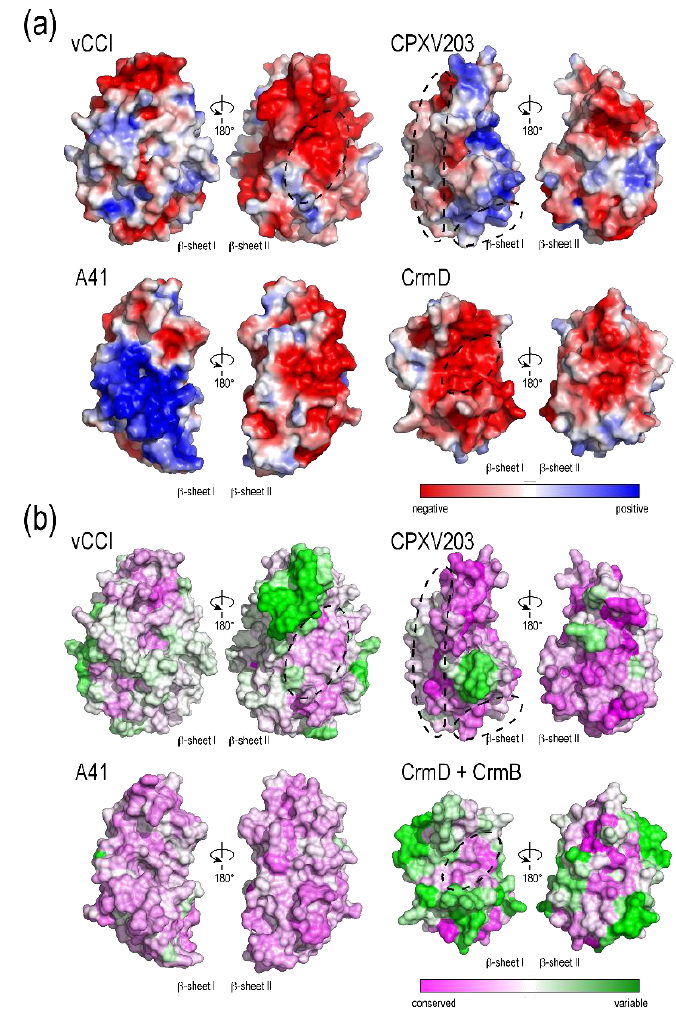
Figure 4. Comparison of PIE domain surface properties. The molecules and orientations are the same as in Figure 1. ( a ) Electrostatic potential surfaces calculated using APBS [52]. Negative charge in red and positive charge in blue from −3kT/e to +3kT/e. Crystallographically observed contact surfaces for ligand are circled; ( b ) Sequence conservation within individual families was mapped to the molecular surface and colored magenta for highly conserved and green for variable. Because so few CrmD exist and CrmB and CrmD are closely related, sequences for CrmB and CrmD SECRET domains were aligned and conservation mapped to the CrmD molecular surface.